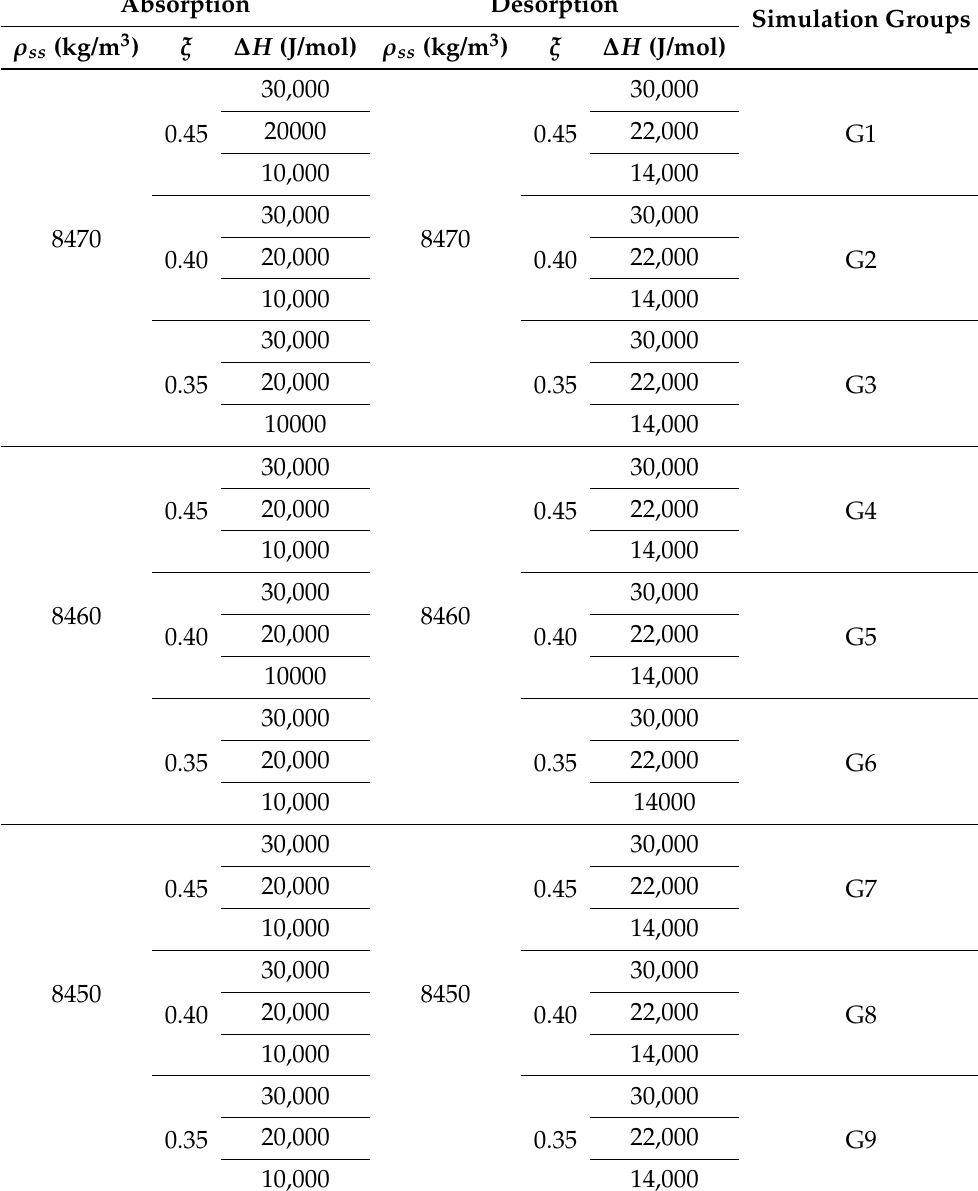
Table 4. Possible combinations for the variation of